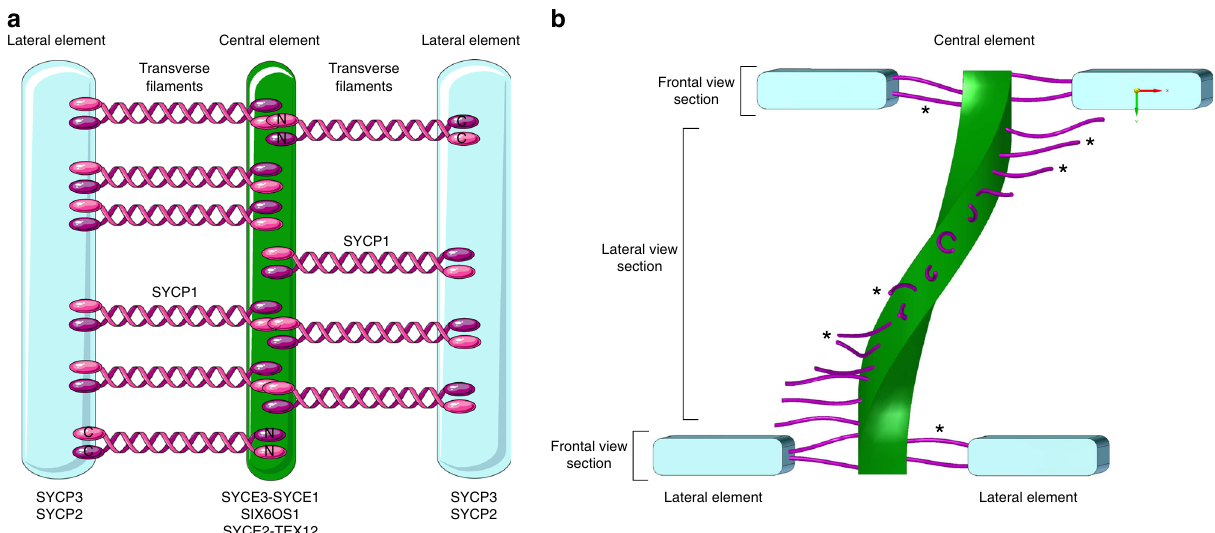
Fig. 1 The murine synaptonemal complex. a Schematic representation of the tripartite SC structure of mouse showing the two lateral elements (LEs) consisting of SYCP2 and SYCP3 fl anking the central element composed of SYCE1/2/3, Tex12, and SIX6OS1. The transverse fi lament protein SYCP1 is connecting the lateral element and the central element with the SYCP1 C terminus residing in the lateral and the N terminus in the central element 32 . b Schematic representation of the helical structure of the SC exposing frontal view sections and lateral view sections. Lateral elements (SYCP3, SYCP2) in blue, central element (SYCE3-SYCE1, SIX6OS1, and SYCE2-TEX12) in green, transverse fi laments (SYCP1) in purple in accordance with a . Individual transverse fi laments are further marked with asterisks. The lateral elements are not displayed in the lateral view section to expose the central element and transverse fi